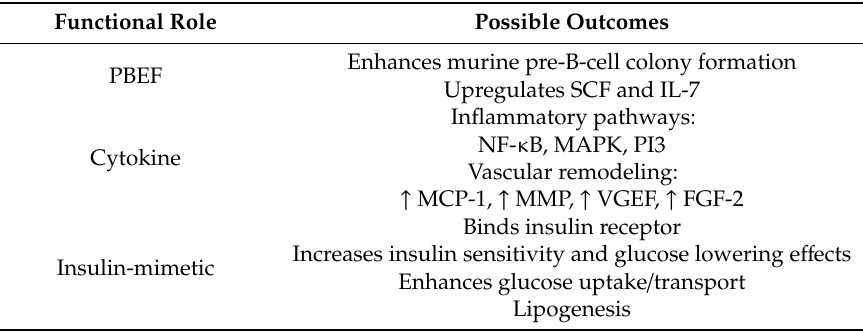
Table 2. Functional roles of extracellular visfatin